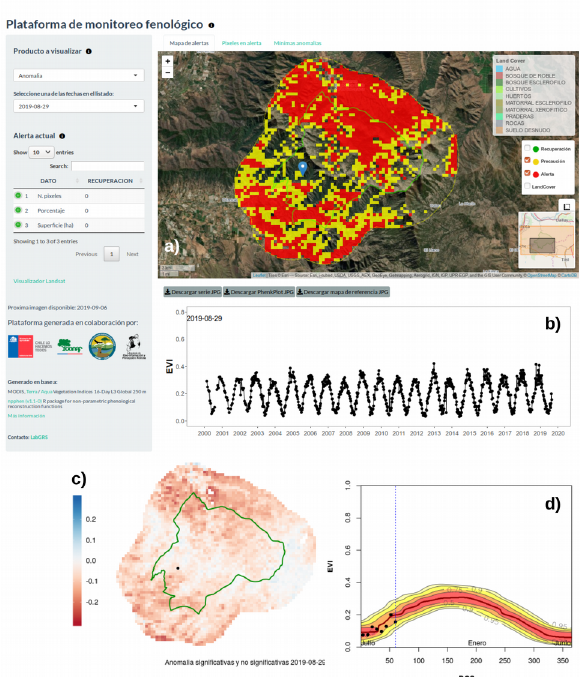
Figure 3 . Web-platform main page displaying the a) warning map based on EVI anomalies and probabilities; b) EVI time series of a selected pixel; c) EVI anomaly map for the selected date; d) annual EVI cycle (2000-2018) with confidence intervals and the current growing season (dark dots) time series is displayed (Figure 3-b) together with its annual phenology (kernel density estimation using all EVI values of growing season represented by black dots (Figure 3-d). Finally, the EVI anomaly map for the entire park and buffer is provided on the lower left part of the platform for the selected date (Figure 3-c). All maps and plots can be downloaded as JPG files by pressing the corresponding bottom in the